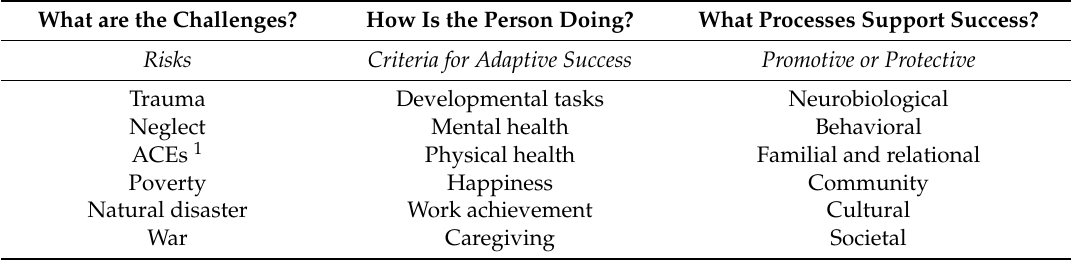
Table 1. Core questions in resilience studies of individuals and examples of constructs